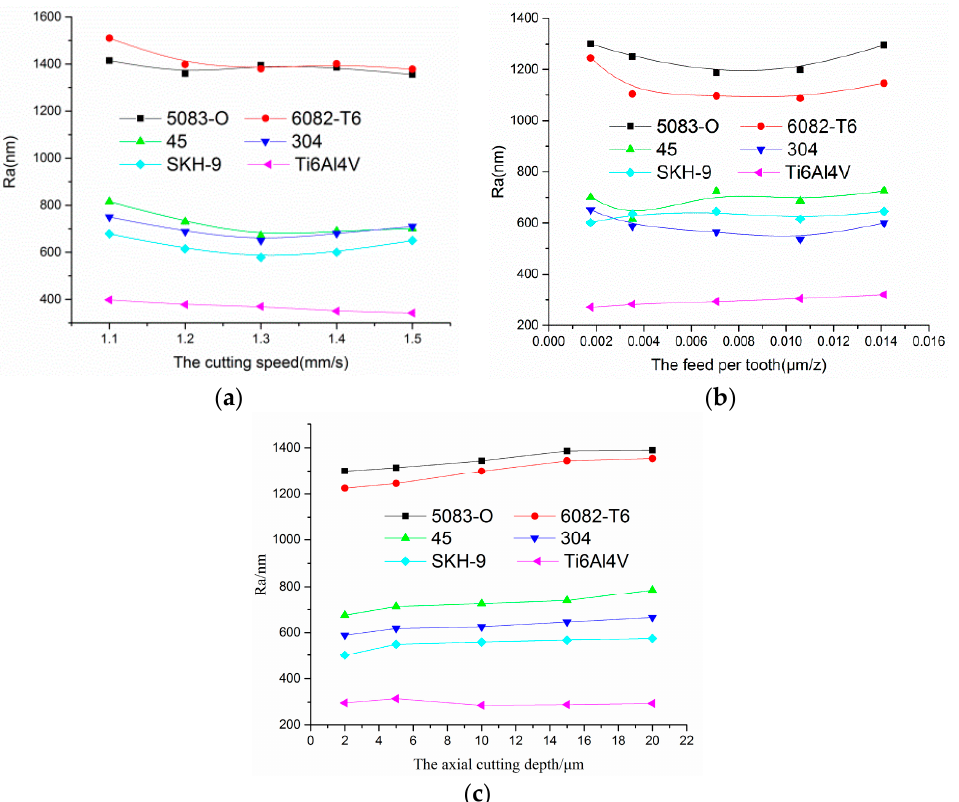
Figure 12. Influence of milling parameters on surface roughness of different materials. ( a ) Change curves of R a with the cutting speed ( f s = 20 µm/s, a p = 10 µm). ( b ) Change curves of R a with the feed per tooth ( n = 83,200 rpm, a p = 10 µm). ( c ) Change curves of R a with the axial cutting depth ( n = 83,200 rpm , f s = 20 µm/s).